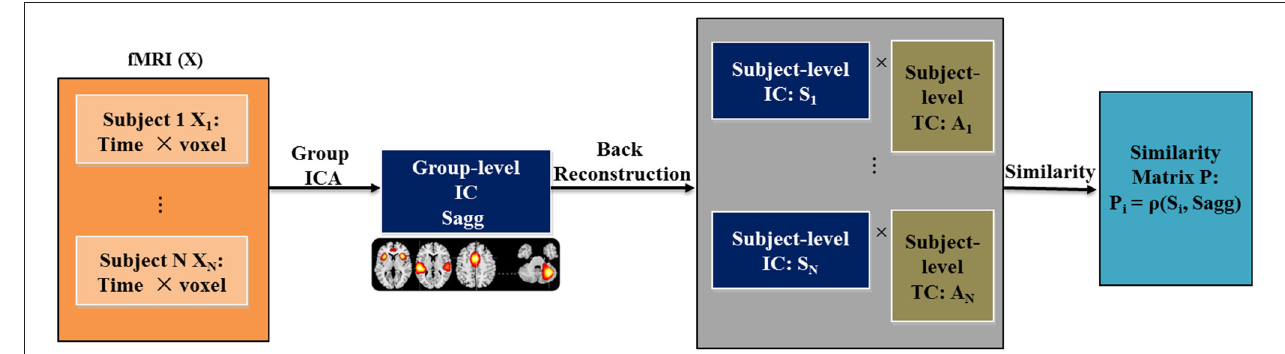
FIGURE 1 | Graphic presentation of the proposed similarity matrix estimation.